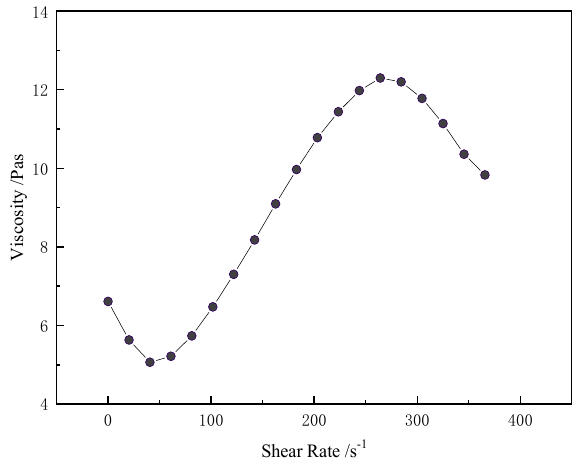
Figure 4. The rheological behavior of